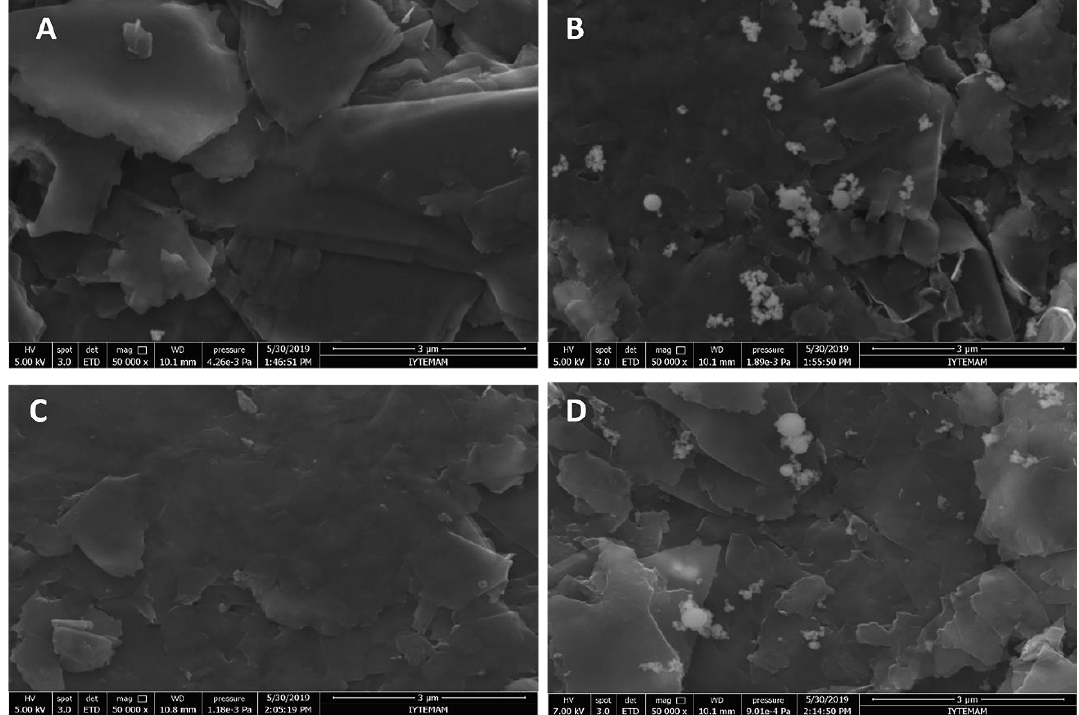
Figure 1. SEM images of the PGEs ( A ), HaP-PGEs ( B ), IL-PGEs ( C ) using identical acceleration voltage 5.0 kV, and HaP-IL-PGEs ( D ) using identical acceleration voltage 7.0 kV with the resolution at 3 µ m,